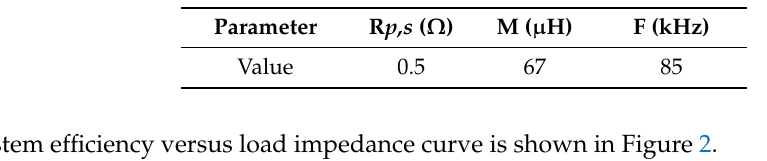
Table 1. Parameter table of system efficiency and load impedance analysis.